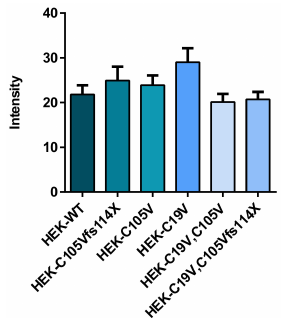
Figure A1. Comparison of the light intensity for quantification of WT-hTSH and mutants. For that HEK293 cells were transient transfected with WT-hTSH or the mutants (all cloned into the nAmCyan-P2A-mCherry vector). For comparison, the light intensity of AmCyan fluorescent protein was measured. Data are expressed as mean ± SEM of four independent experiments with 10 measurements each ( n = 40). For statistical analysis, one-way-ANOVA with the Kruskal-Wallis test was used to test the mutants against the WT.